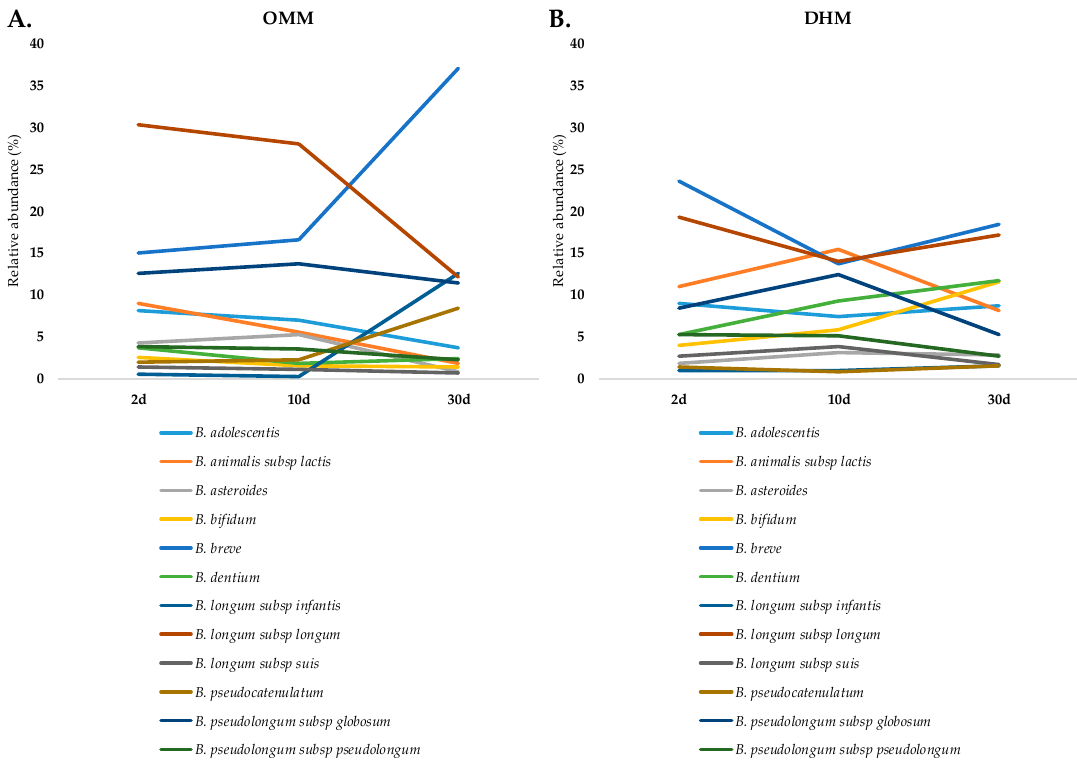
Figure 1. Bifidobacterium evolution. Evolution of Bifidobacterium species in ( A ) the own mother’s milk (OMM) group and ( B ) the donor human milk (DHM) group during the first month of life.